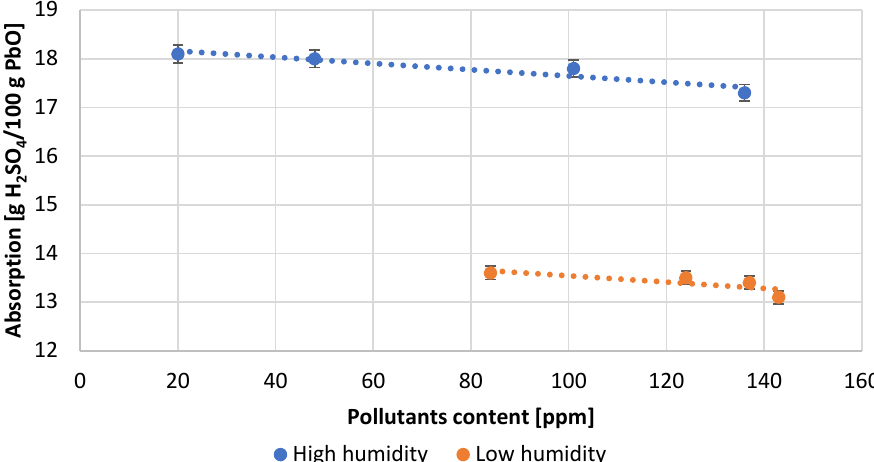
Figure 9. Dependence of acid absorption on pollutants content.